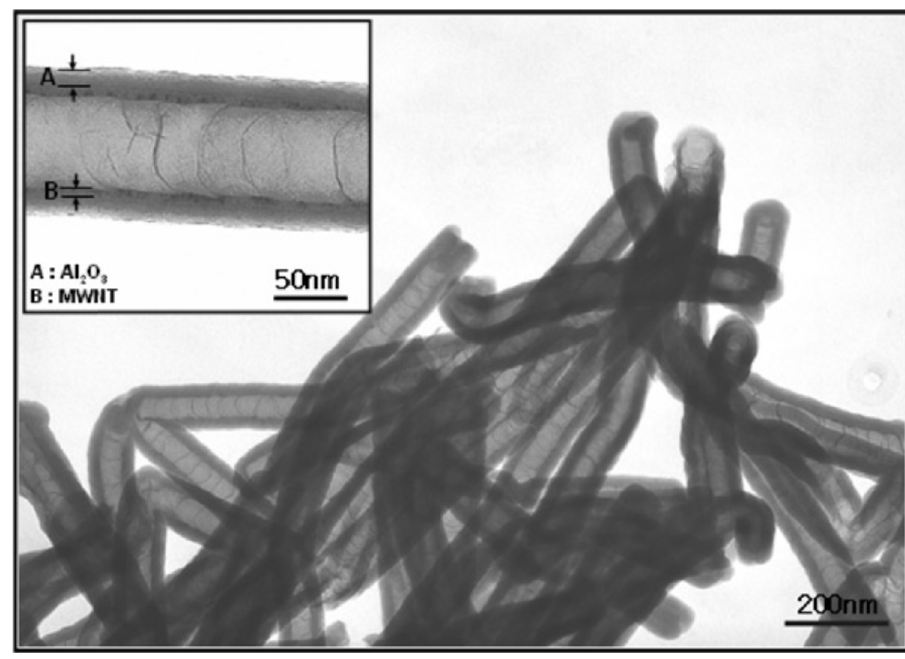
Figure 2: Transmission electron microscopic image of Al 2 O 3 - coated MWCNTs. The insert shows a cylindrical Al 2 O 3 layer ( A ) coating a particular multi - walled CNTs and the multi walls ( B ) of this multi - walled